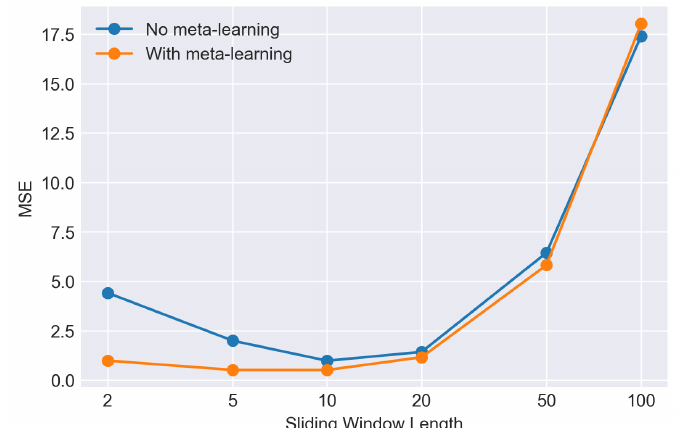
Figure 6. The figure shows mean squared error (MSE) with sweeping the sliding window length. The MSE is calculated from the last 1k time steps of the total 5k time steps simulation. The blue line is the results from the model without meta-learning. The orange line is the results from the model with